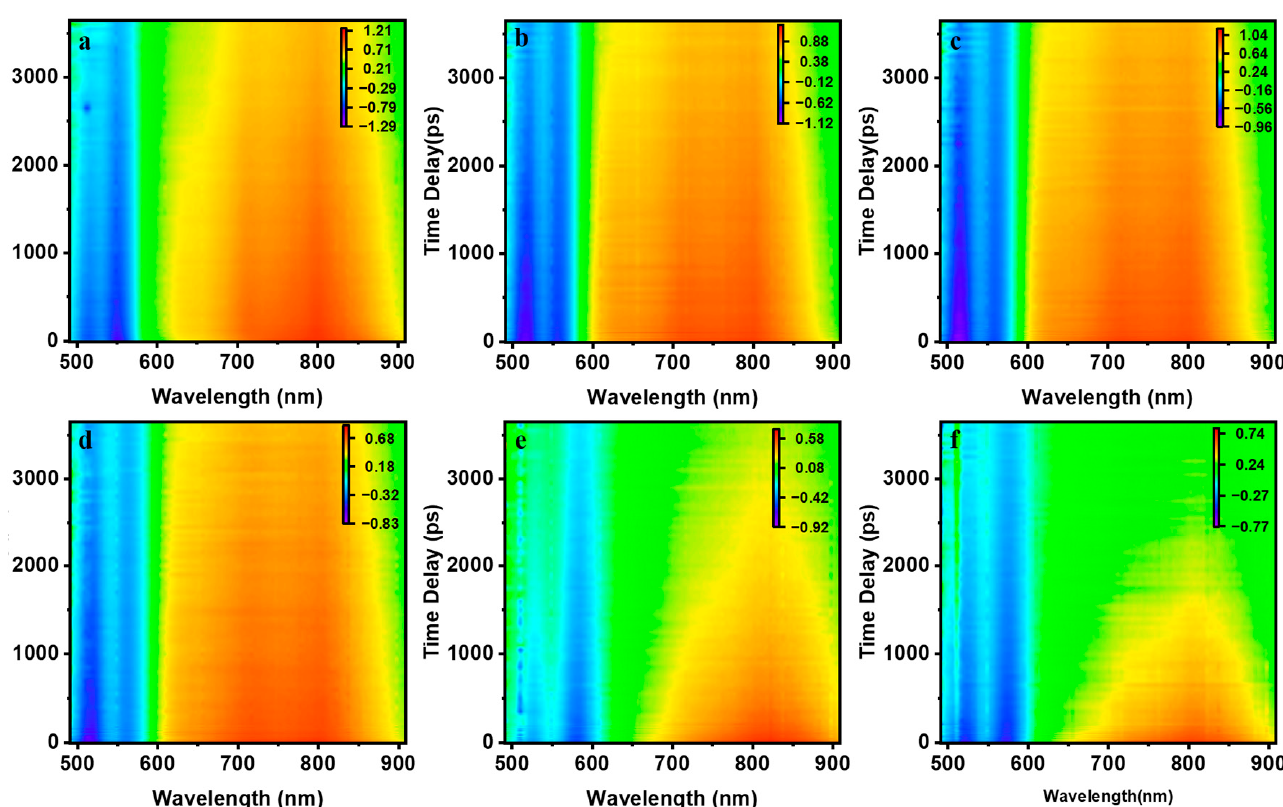
around 570 nm. The little difference in the intensity ratios of the two negative signals (570 nm/520 nm) lies in the fact that the fluorescence peak at 570 nm starts to become distinct when the water percentage reaches 40% (Figure 3c), which enhances the transient absorp- tion signal of SE at 570 nm and thus breaks the decreasing trend of the intensity ratios of Figure 4. Two-dimensional (2D) transient absorption spectra of PDI-III with different water percent- Figure 4. Two-dimensional (2D) transient absorption spectra of PDI-III with different water percent- the two negative signals (570 nm/520 nm). ages: ( a ): 0%; ( b ): 10%; ( c ): 20%; ( d ): 30%; ( e ): 40%; and ( f ): 50%. ages: ( a ): 0%; ( b ): 10%; ( c ): 20%; ( d ): 30%; ( e ): 40%; and ( f ): 50%.